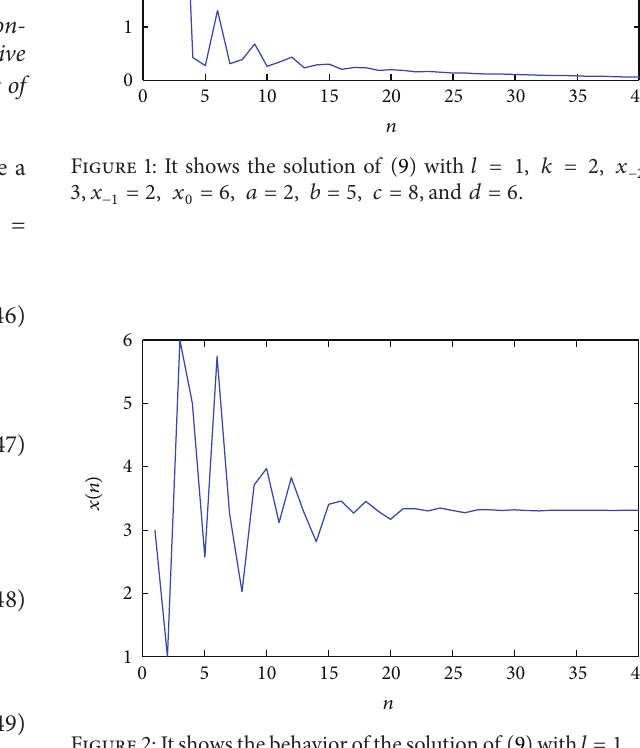
Figure 2: It shows the behavior of the solution of (9) with 𝑙 = 1, 𝑘 = = 3, 𝑥 = 1, 𝑥 = 6, 𝑥 = 5, 𝑎 = 9, 𝑏 = 13, 𝑐 = 3, 𝑥 −3 −2 −1 0 0.1, and 𝑑 = 2 .